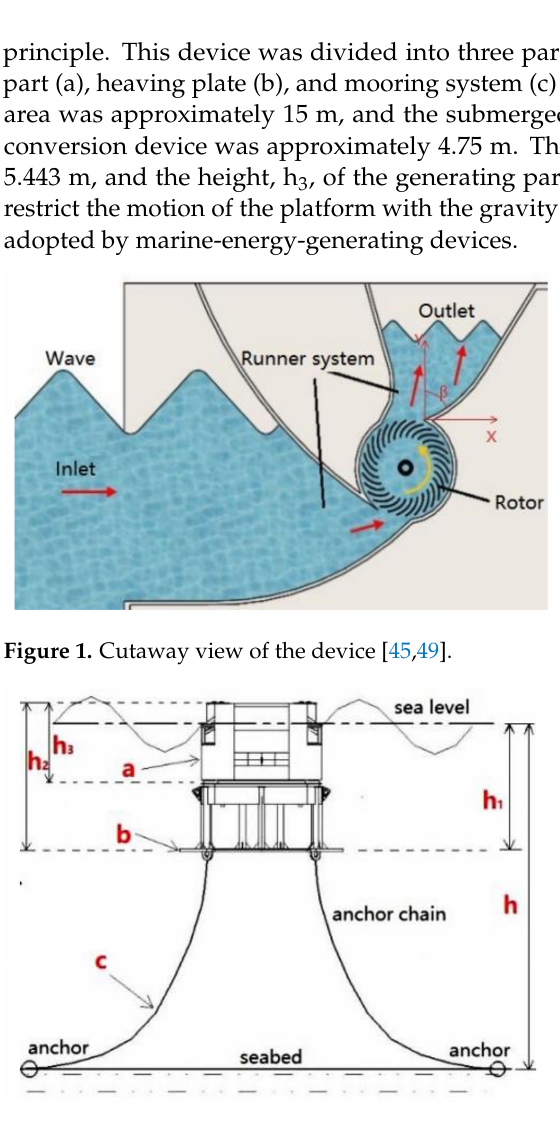
Figure 2. Wave energy converter